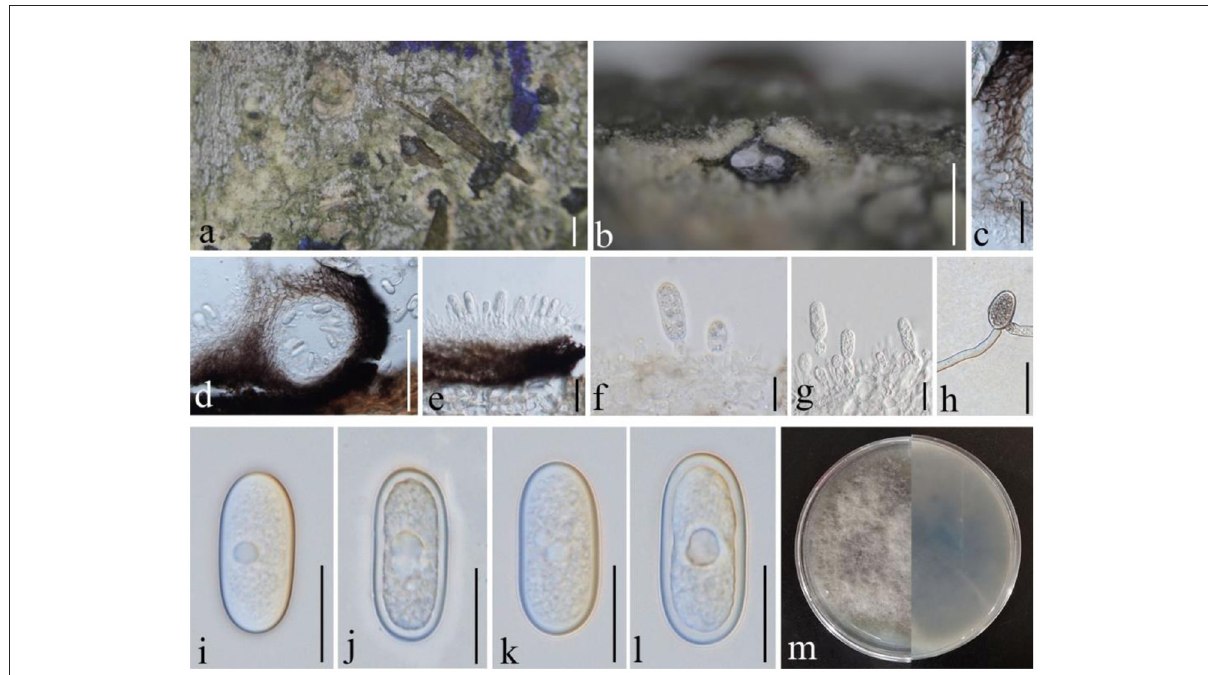
FIGURE5 Diplodia mutila (GMB1381, a new host record). (a) Appearance of conidioma on the host. (b,d) Vertical sections of conidiomata. (c) Conidiomata walls. (e–g) Conidia attached to conidiog-enous cells. (h) Germinating conidium. (i–l) Conidia. (m) Cultures on PDA. Scale bars: (a) = 500, (b) = 200, (c,g,h) = 20, (d) = 100, (e) = 25, (f) = 10, and (i–l) = 15 µ